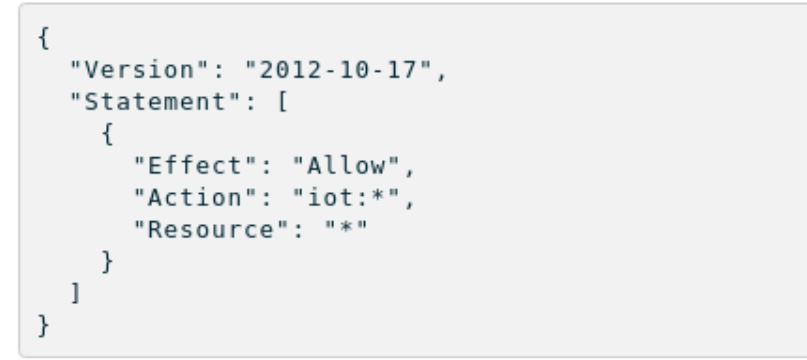
Figure 7. Default device policy in Amazon Web Service (AWS).